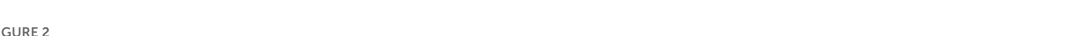
FIGURE2 in GSE93272 ( p -value < 0.05, log fold change > 0.05, non-overlapping DEGs with other subpopulation). (C) Mean-variance trend after processed voom in GSE93272. (D) Optimal subpopulations from the total number of 232 RA patients in GSE93272 by ReDisX. (E) PCA and t-SNE visualization of the total number of 232 RA patients in GSE93272. (F) Mean-difference (MD) plots for the ReDisX-based cluster 1 of RA patients to the healthy controls [label 1 (red dot) represents the up-regulated genes in the upper panel, the label –1 (blue dot) represents the down-regulated genes at the lower panel]. (G) MD plots for ReDisX-based cluster 2 of the RA patients to the healthy controls [label 1 (red dot) represents the up-regulated genes, and the label –1 (blue dot) represents the down-regulated genes]. (H) MD plots for ReDisX-based cluster 3 to the healthy controls [label 1 (red dot) represents the up-regulated genes, label –1 (blue dot) represents the down-regulated genes]. (I) Volcano plot for ReDisX-based cluster 1 compared to the healthy controls, highlighting top 50 log 2 fold change genes in blue. (J) Volcano plot for ReDisX-based cluster 2 compared to healthy controls, highlighting top 50 log 2 fold change genes in blue. (K) Volcano plot for ReDisX-based cluster 3 compared to healthy controls, highlighting top 50 log 2 fold change genes in blue. (L–N) cytoHubba-identified hub gene analysis to the GeneMANIA network for ReDisX-based clusters using the MCC ranking algorithm. The hub genes for cluster 1 (L) , cluster 2 (M) , the cluster 3 (N) were